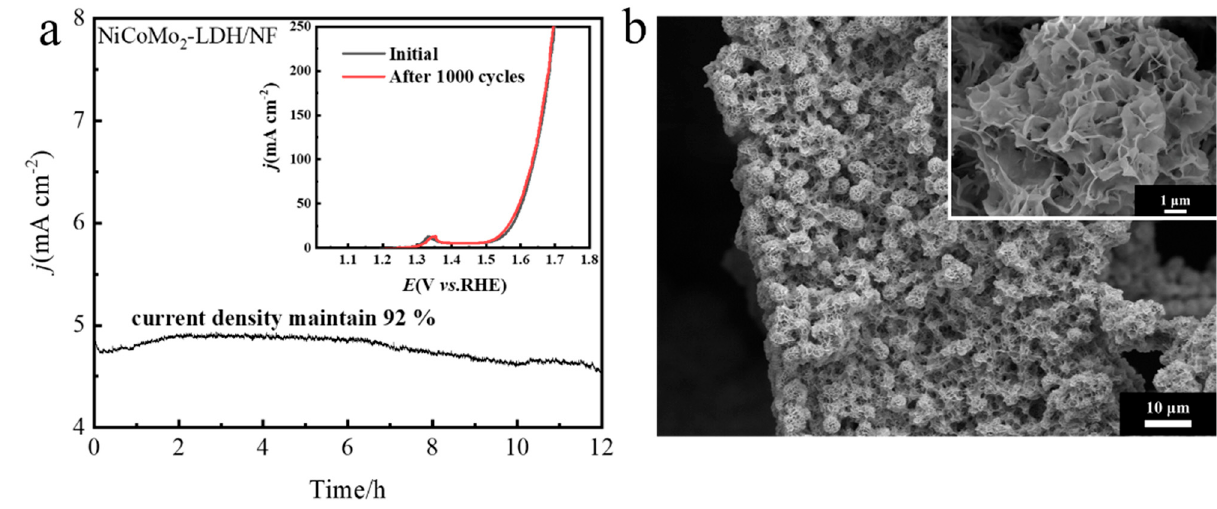
Figure 8. Stability test. ( a ) I-T curve of the NiCoMo 2 -LDH/NF electrocatalyst, initial LSV curve and LSV curve after 1000 CV cycles, and ( b ) Low magnification and high magnification inset SEM images after NiCoMo 2 -LDH/NF stability test.